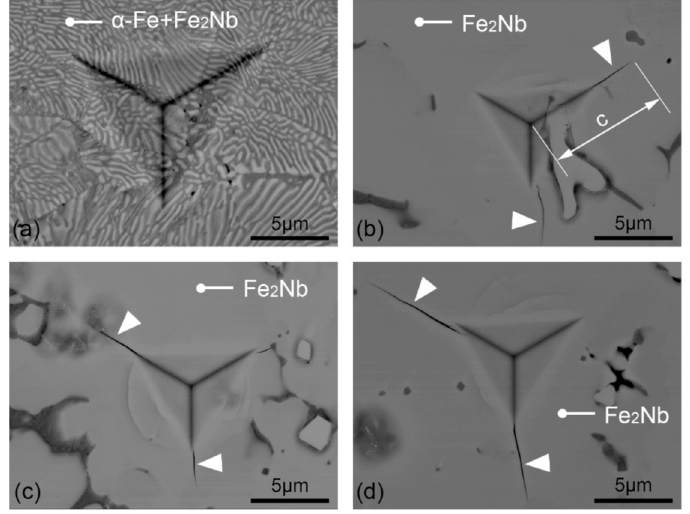
Figure 6. Backscattered electron (BSE) images of impressions in ( a ) the α -Fe + Fe 2 Nb region and ( b – d ) the Fe 2 Nb regions.